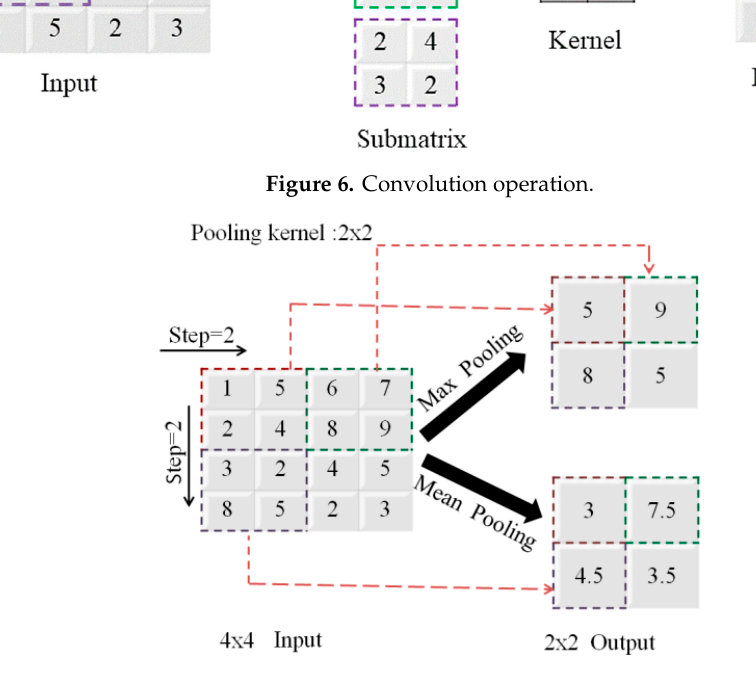
Figure 7. Pooling operation.